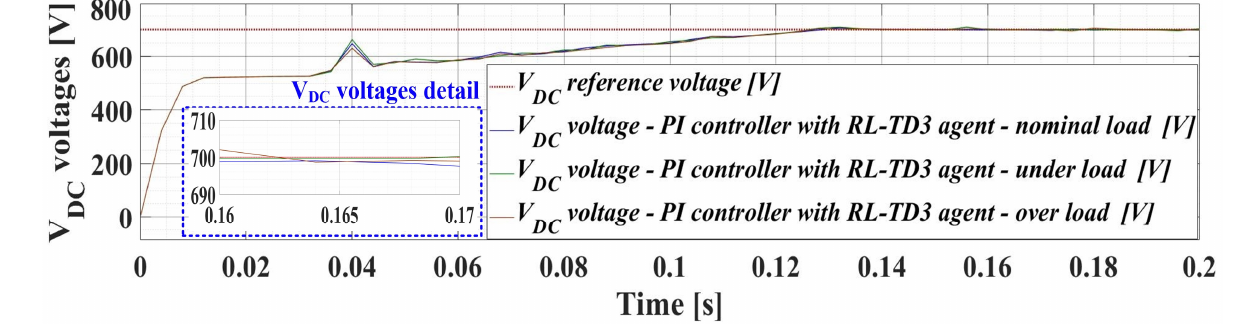
Figure 12. V DC voltages time evolution of the UPQC-APF control system based on FO-Lead-Lag controller in case of nonlinear load.